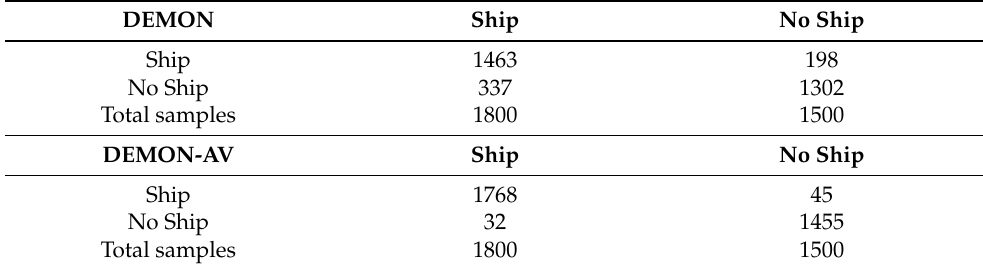
Figure 7. Spectrogram after pre-processing with DEMON-AV for Record-1. Table 1. Detection accuracy on a database of 3300